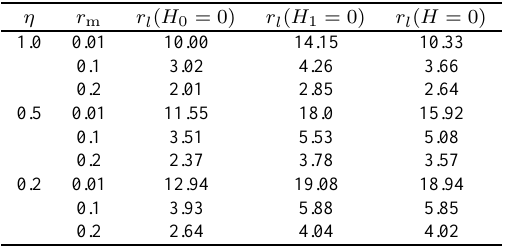
Table 1 Table 1 Effect of mass ratio ( η ) of the two exciters on the